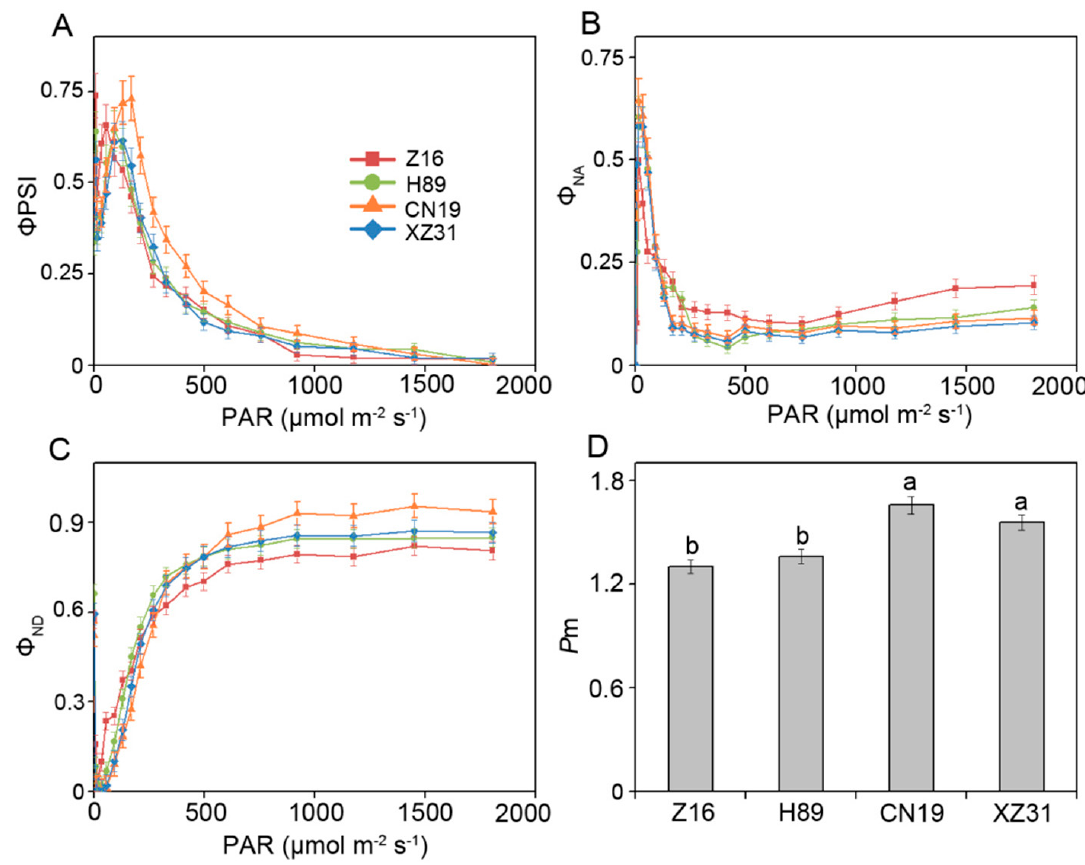
Figure 2. The values of parameters derived from P700 absorbance in leaves of Z16, H89, CN19, and XZ31. Φ PSI ( A ), effective quantum yield of PSI; Φ NA ( B ), quantum yield of non-photochemical energy dissipation of PSI reaction centers due to acceptor side limitation; Φ ND ( C ), quantum yield of non-photochemical energy dissipation in PSI reaction centers due to donor-side limitation ( C ); P m ( D ), maximal P700 signal. Values are means ± SD from four independent biological replicates ( n = 4). Different letters indicate significant differences among Z16, H89, CN19, and XZ31 ( p < 0.05) following Duncan’s multiplication range test. Z16, H89, CN19, and XZ31 present accessions of Triticum monococcum (W2n), Triticum dicoccum (W4n), Triticum aestivum (W6n), and octaploid Triticale (T8n), respectively.